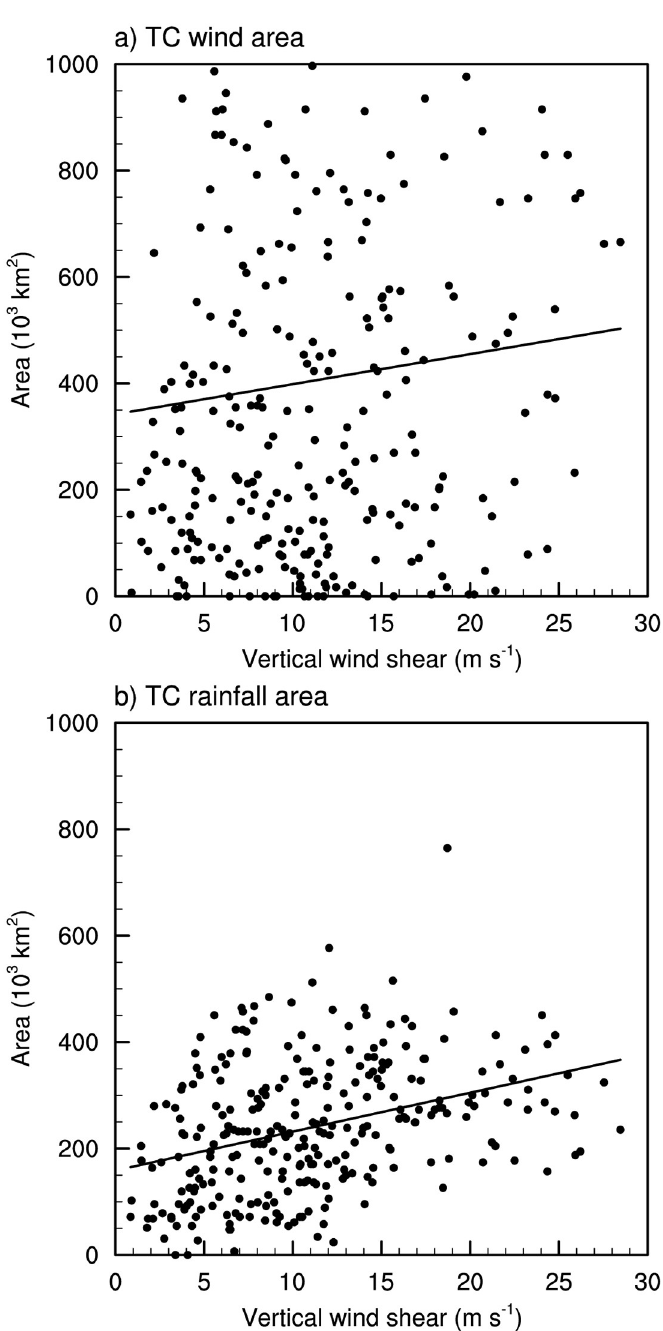
Fig 6. Distributions of the (a) wind area, and (b) rainfall area according to the vertical wind shear. The solid line in each plot denotes the linear regression